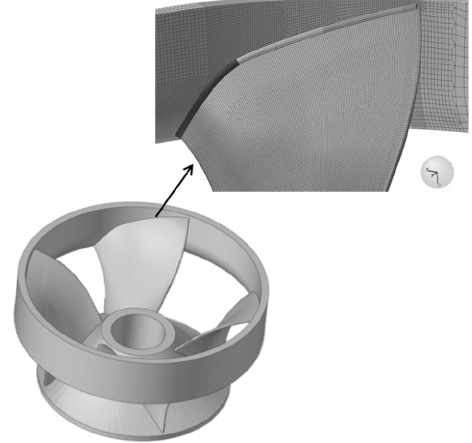
Figure 5. Runner 3D Finite Element Mesh.